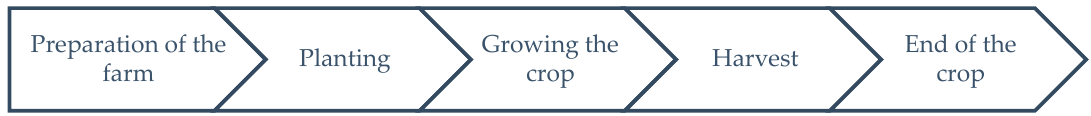
Figure 1. Growing process in greenhouses.